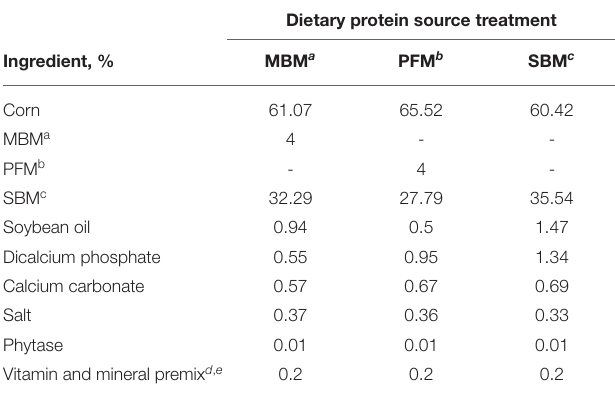
TABLE 1 | Composition of starter diets fed to broilers reared to 21 d-of-age. Dietary protein source